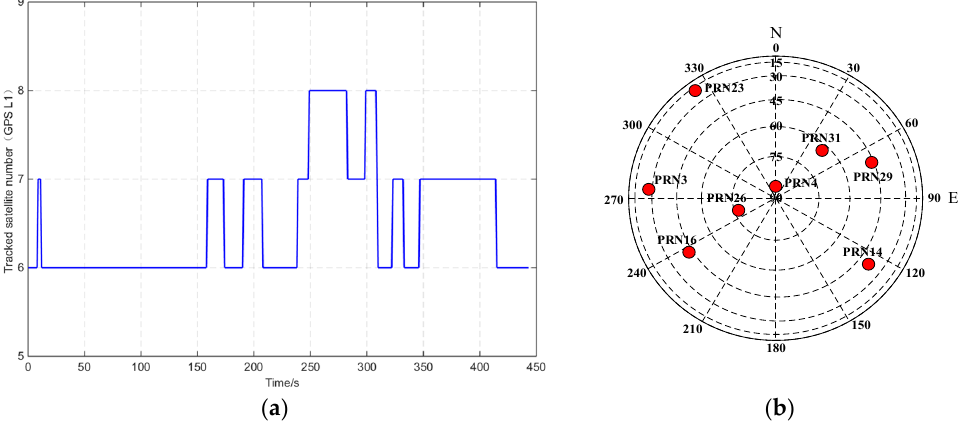
Figure 9. Tracked satellite number and space distribution of GPS L1 receiver. ( a ) Satellite number with time; ( b ) Space distribution.